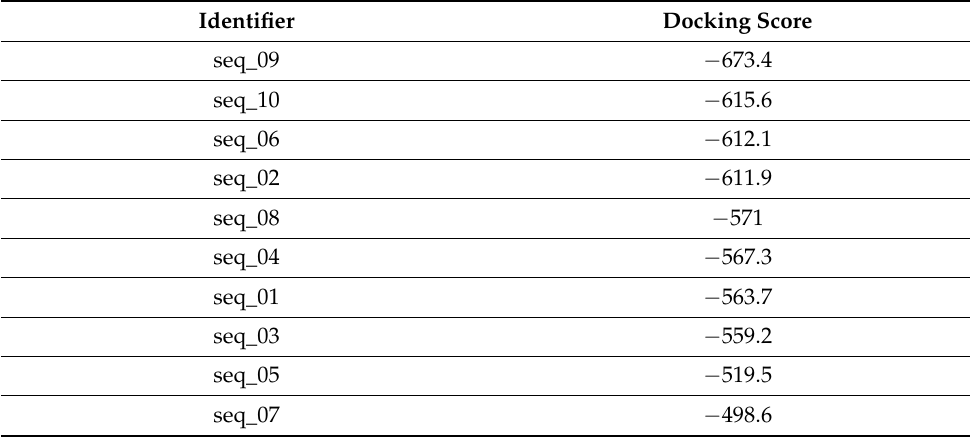
Table 4. Docking results of the newly generated structures.